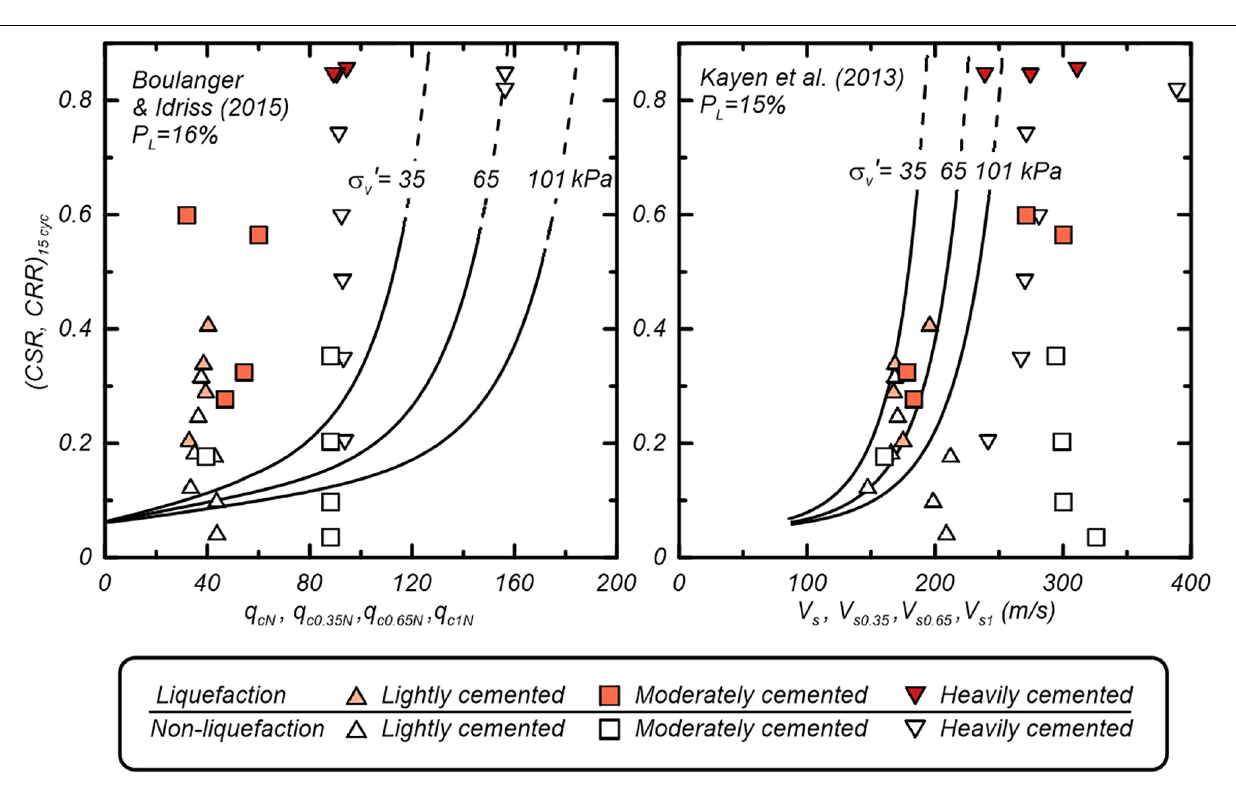
FIGURE 13 | Equivalent uniform cyclic stress ratios versus cone penetration resistance and shear wave velocity in a saturated sand model subject to dynamic loading on the 1-m radius centrifuge, along with case-history based liquefaction triggering correlations used in practice (Reproduced from Darby et al., 2019 with permission from